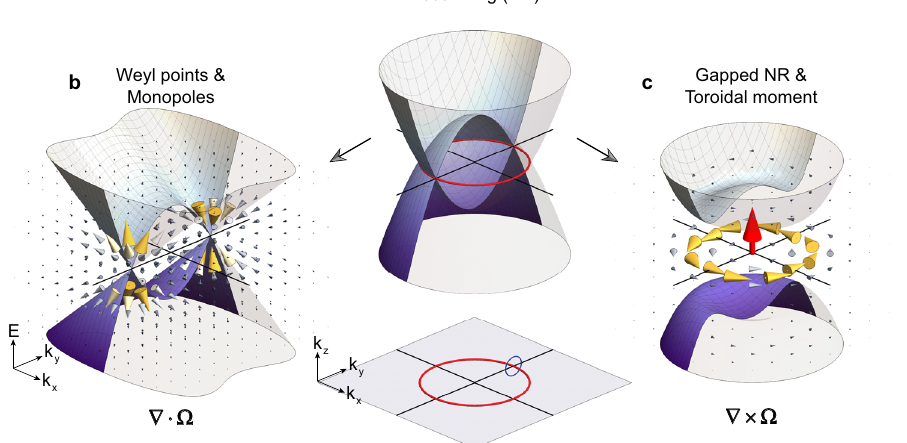
Fig. 1 Monopoles and toroidal moments in the momentum space. a Nodal ring (red ring) and quantized Zak phase (blue loop) protected by mirror symmetry M z . The inset shows the nodal ring in the k -space. b In Weyl semimetals, paired Weyl points serve as sinks and sources (monopoles) of Berry curvature in the momentum space. c Fully gapped nodal ring exhibiting Berry curvature vortex, the momentum-space toroidal moment